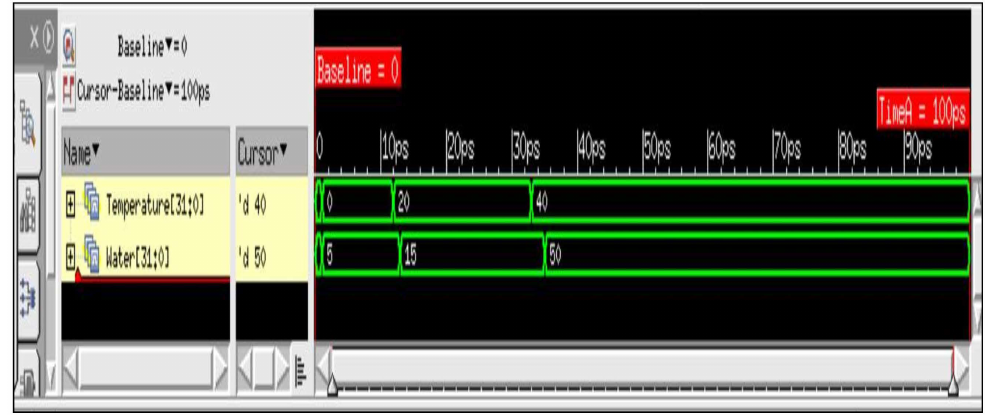
Figure 9. The results of the verification of the Verilog code developed.